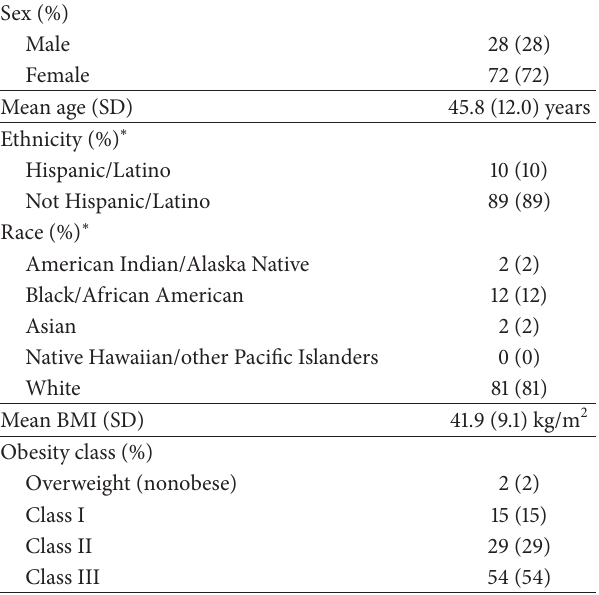
Table 1: Demographic characteristics of 100 adults seeking weight- loss